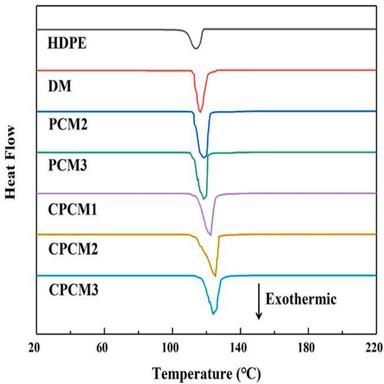
Melting DSC curves of the HDPE, DM, PCMs, and CPCMs. Fig. 8. Solidifying DSC curves of the HDPE, DM, PCMs, and CPCMs.